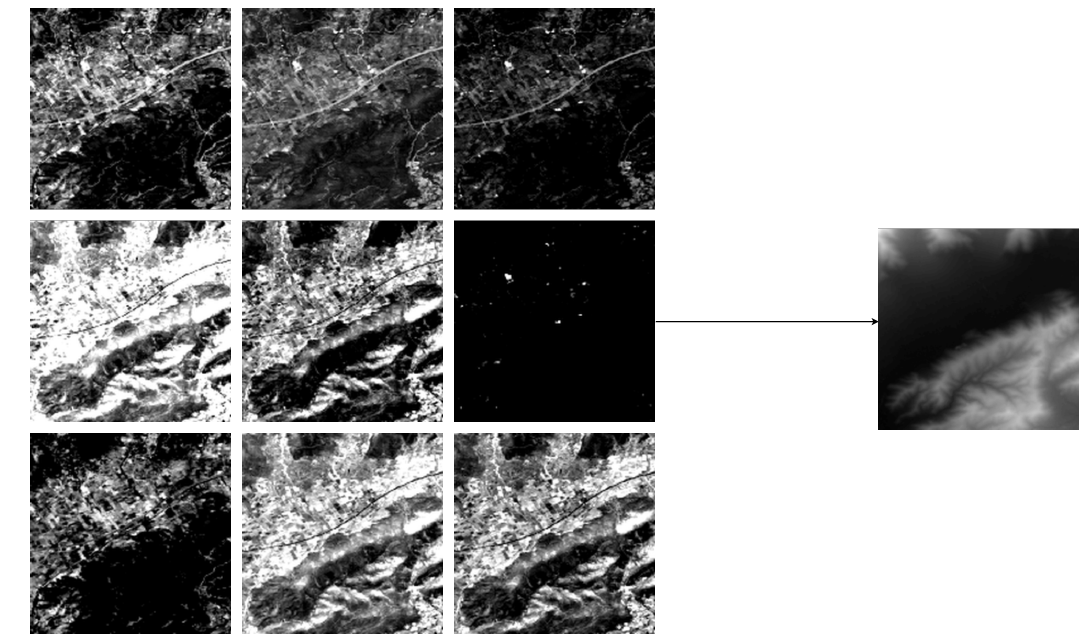
Figure 5. An illustration of the 9-band input described at Table 1, presented from left to right and top to bottom. The higher variety in the input wavelengths provides auxiliary information for the DEM prediction. Table 1. Details of the bands used in the Multispectral extension of the satellite-imagery